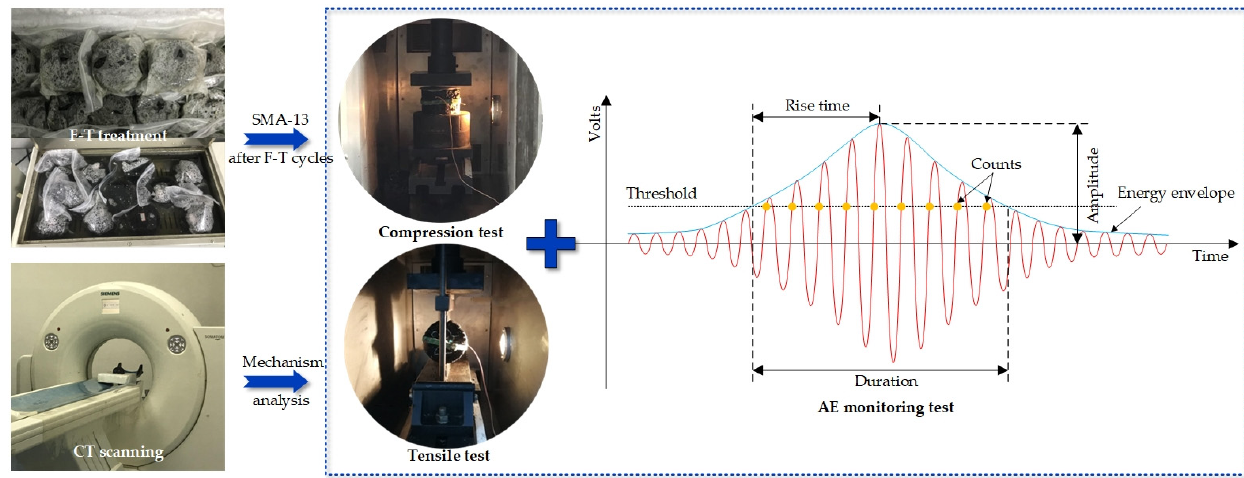
Figure 3. The experimental procedure of this study.